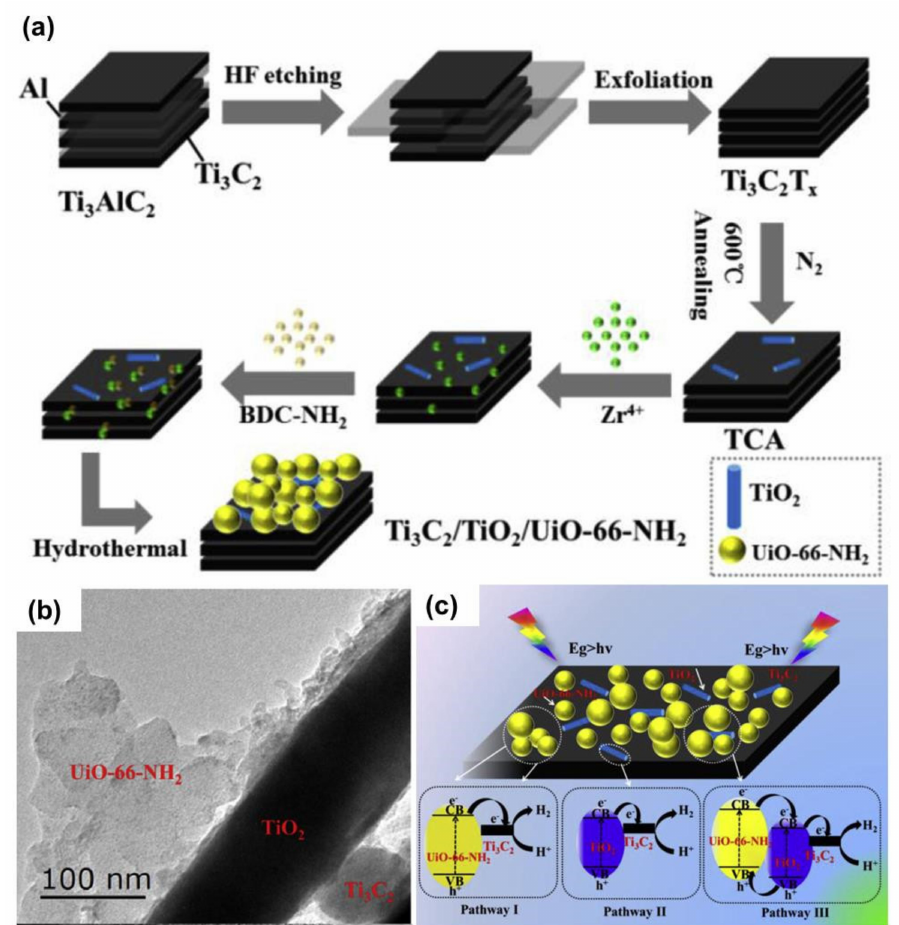
Figure 9. ( a ) Route for the synthesis of Ti 3 C 2 T x / TiO 2 / UiO-66-NH 2 ternary composite, ( b ) TEM image of the Ti 3 C 2 T x / TiO 2 / UiO-66-NH 2 ternary composite, and ( c ) working mechanism of ternary composite photocatalyst for HER. Reproduced with permission from reference [88]. Copyright Elsevier B.V.,